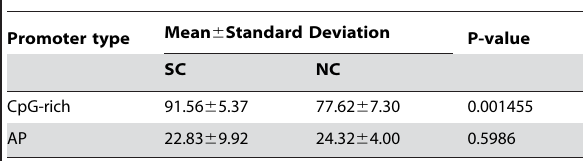
Table 8. The distribution of promoter usage in the SCs and the negative controls (NCs); CpG-richness and AP usage are considered.